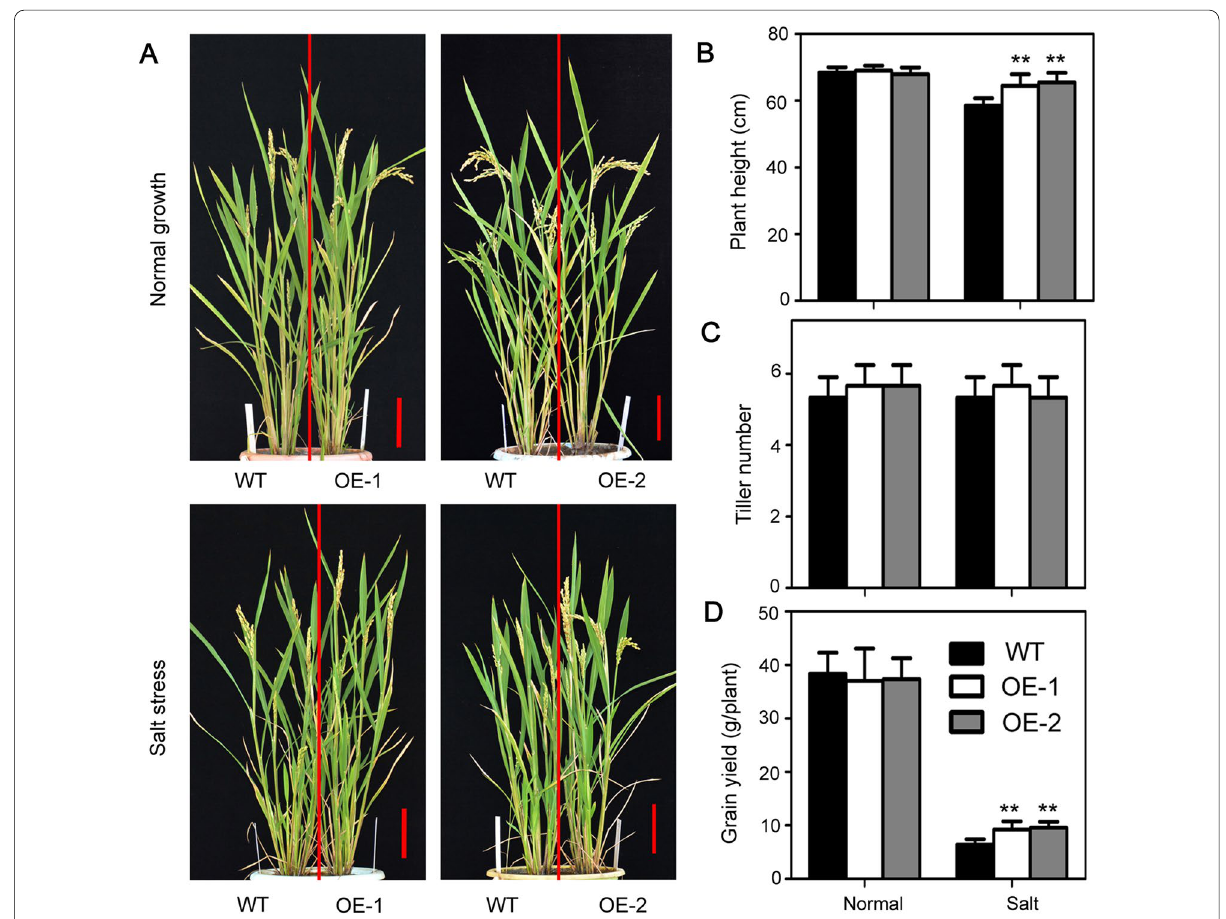
Fig. 2 Growth status of the AtSOAR1 ‑transgenic plants under salt stress at the reproductive stage. A Phenotypic comparison of wild‑type and AtSOAR1 ‑transgenic plants OE‑1 and OE‑2 grown under normal and salt stress at the reproductive stage. Two‑week‑old seedlings were transplanted to pot containing soil with or without 0.15% NaCl (ratio of salt weight to that of dry soil), which were then cultured for total growth period with common agriculture management. Three independent biological determinations were conducted and similar results were obtained. B – D Statistics of the plant height B , tiller number C and productivity per plant D of wild‑type, OE‑1 and OE‑2 under normal growth and salinity stress conditions. Student’s t test was used for comparing the plant height, tiller number or grain yield of each overexpression line with those of wild‑type plants (with significant differences at ** P <